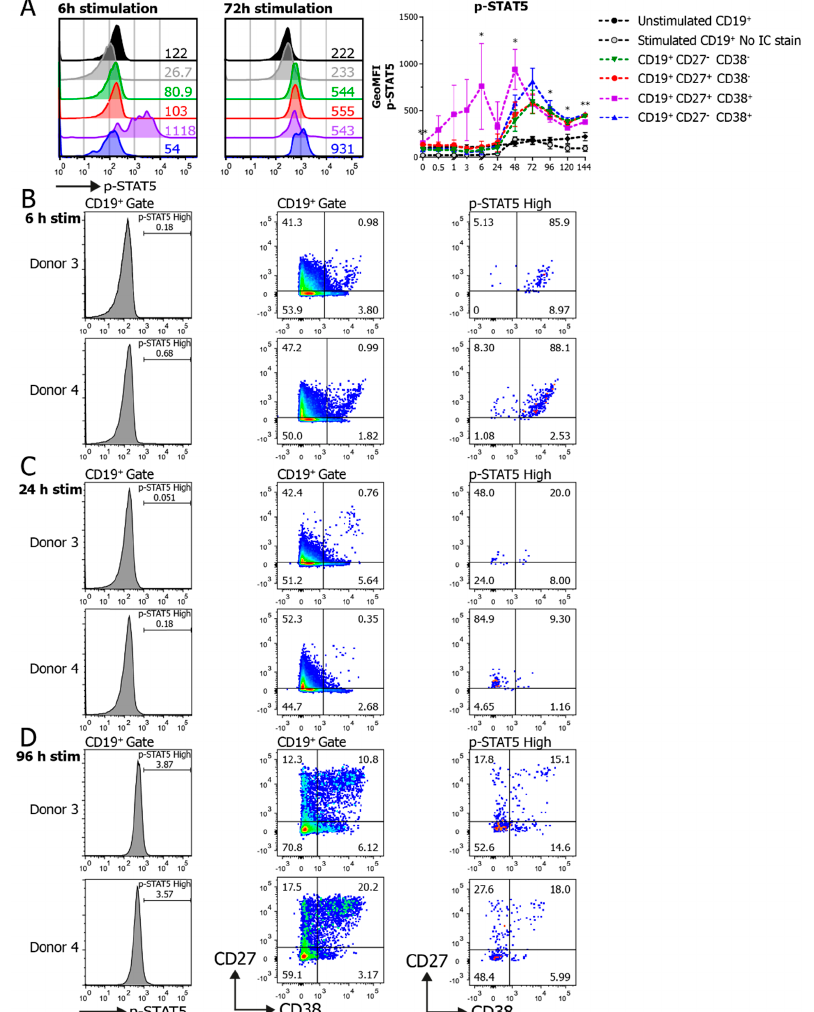
Figure 3. Phosphoflow analysis of STAT5 phosphorylation unveils heterogeneity over time in CD27/CD38 subpopulations . Human B cells ( n = 3–4) were stimulated with a human-CD40L- expressing 3T3 feeder layer, an anti-Ig F(ab) 2 mix (5 ug/mL) targeting IgM/IgG/IgA and recombinant IL-4 (25 ng/mL) and IL-21 (50 ng/mL) cytokines, and multiple signaling proteins were analyzed by phosphoflow analysis over the course of a 6-day culture. ( A ) Representative histogram overlays of p- STAT5 staining in CD19 + and CD27/CD38 subpopulations after 6 and 72 h stimulation (left), and the quantification of the GeoMFI of p-STAT5 within the different subpopulations over the course of 6 days of culture (right). Values depicted next to histograms represent the corresponding GeoMFI. n = 3–4; p values were calculated using a mixed-effect analysis with Tukey’s multiple-comparison test; * p < 0.05 and ** p < 0.01. Significance is shown if there was a significant difference between the green, red, purple or blue CD27/CD38 subpopulations. ( B–D ) Histograms of p-STAT5 expression in the CD19 + population in Donor 3 and Donor 4 (left), and the corresponding CD27/CD38 expression profiles in the CD19 + population (middle) and high-p-STAT5-expressing population (right) after 6 h ( B ), 24 h ( C ) or 96 h ( D ) of stimulation.